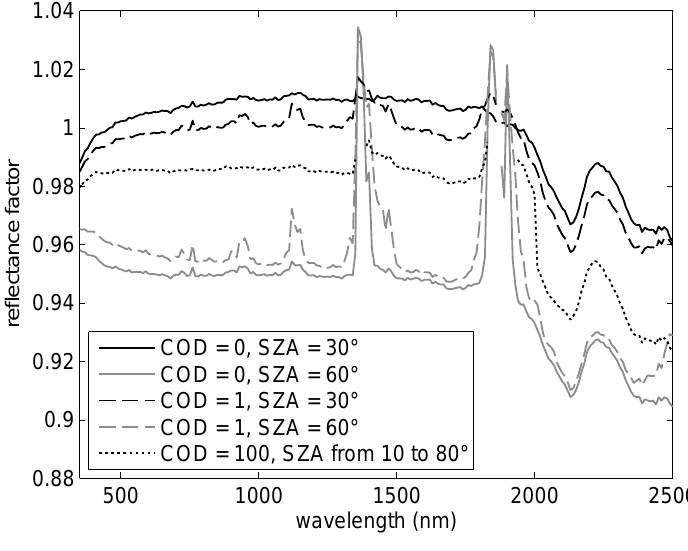
Figure 4. Reflectance factor of Spectralon whitepanel for different cloud optical depths and solar zenith angles calculated with polynomial approximations of